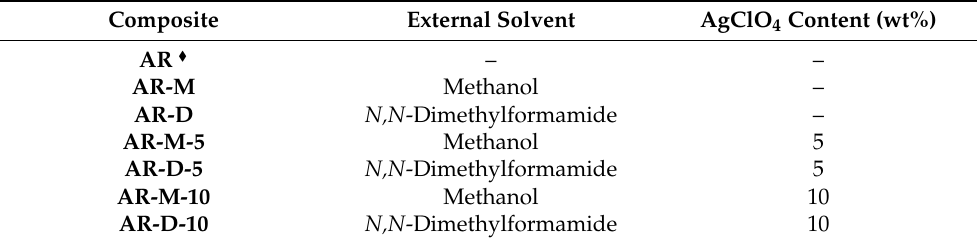
Table 1. Prepared nanocomposites ( (cid:7) AR: acrylic